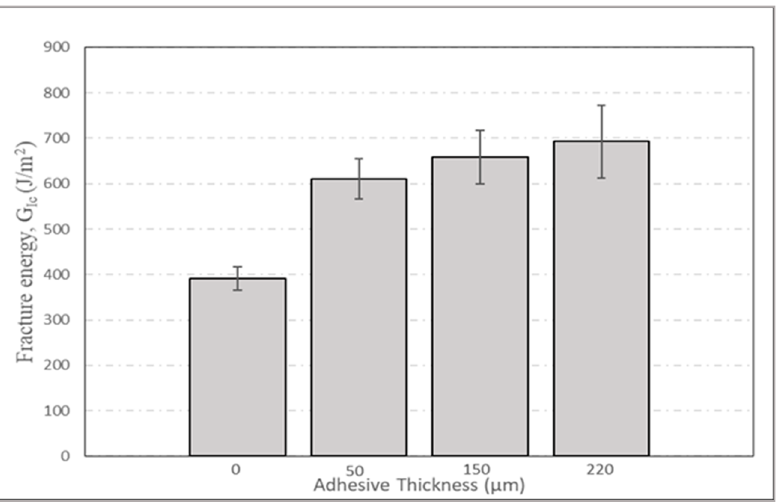
Figure 13. Variation of fracture energy with interleaving film thickness in Mode I. Table 3. Effect of interleaving film thickness on the fracture energy in Mode I.